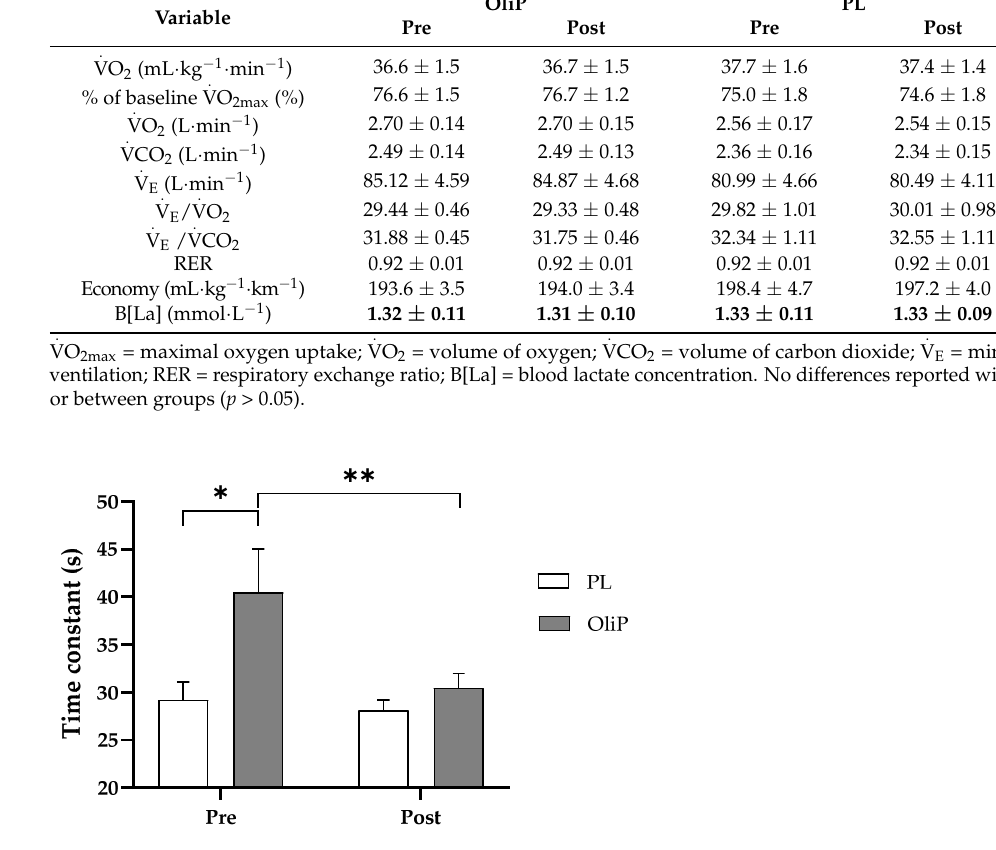
V̇ CO 2 = volume of carbon dioxide;